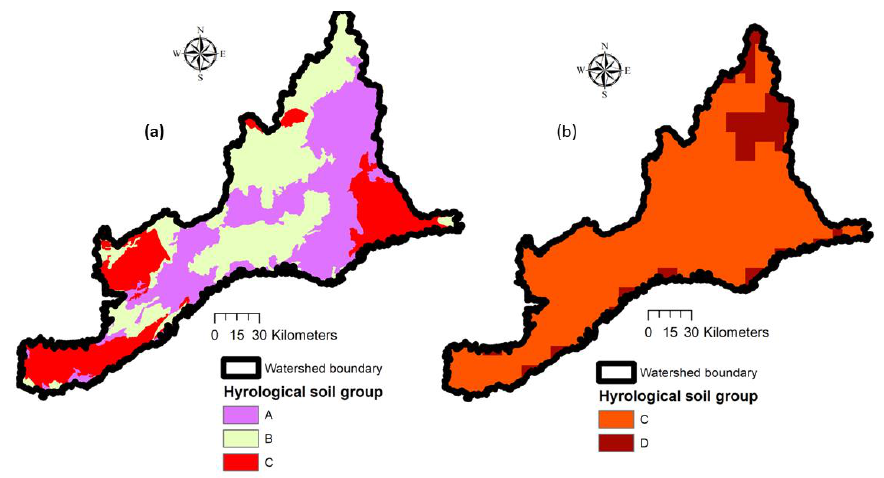
Figure 3. Two soil coverage maps the for Northern Lake Erie basin at spatial scale: ( a ) Food and Agricultural Organization (FAO) soil with 1:5 M resolution. ( b ) Soil Landscapes of Canada (SLC) with 1:1 M resolution.